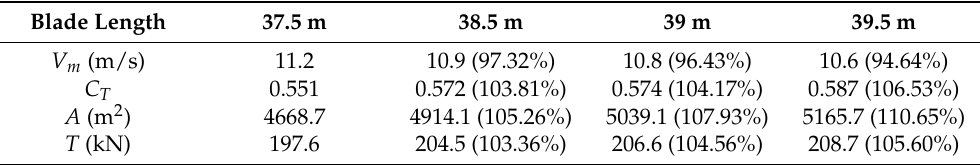
Table 6. The wind speed and thrust coefficient under the maximum thrust force for different blade lengths. The variation percentage in the parenthesis is calculated based on the turbine with 37.5 m blades as